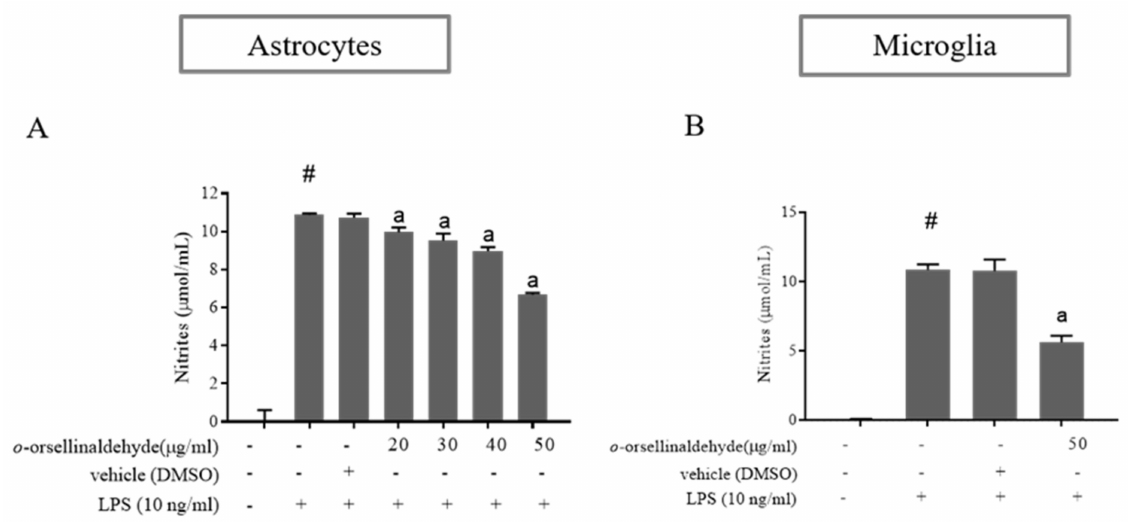
Figure 3. o -Orsellinaldehyde inhibits LPS-mediated NO production in astrocytes and microglia cells. Cells were incubated with the indicated concentrations of o -orsellinaldehyde for 30 min before treatment, and with LPS (10 ng/mL) for 24 h. The medium was collected for NO measurement by Griess reaction. ( A ) Concentrations of NO in astrocytes. ( B ) Concentrations of NO in microglia. Results are shown as the mean of the nitrite production ± SD of four independent experiments. Statistically significant differences ( p ≤ 0.05) of LPS compared to the control condition are expressed as a “#”. Statistically significant differences ( p ≤ 0.05) between LPS conditions are expressed with an